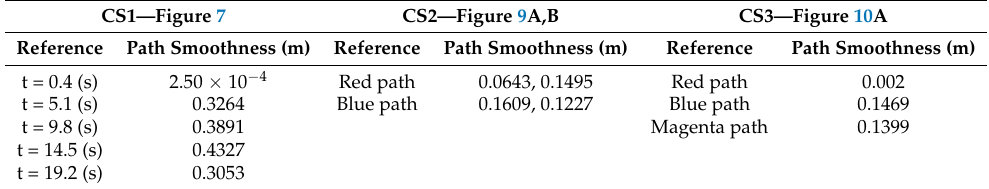
Table 5. Generated path smoothness for study